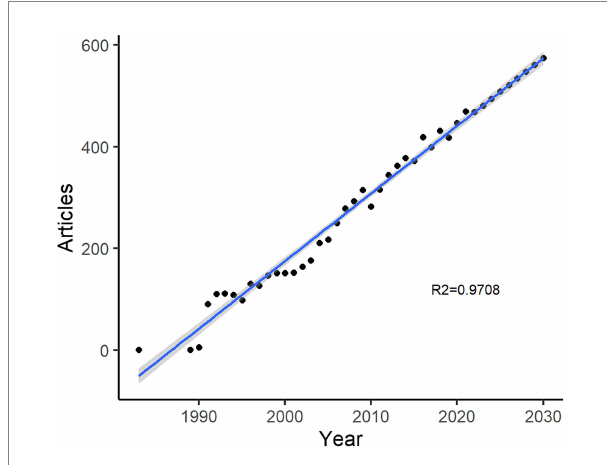
FIGURE 2 Number of annual articles on heart failure and depression by years.